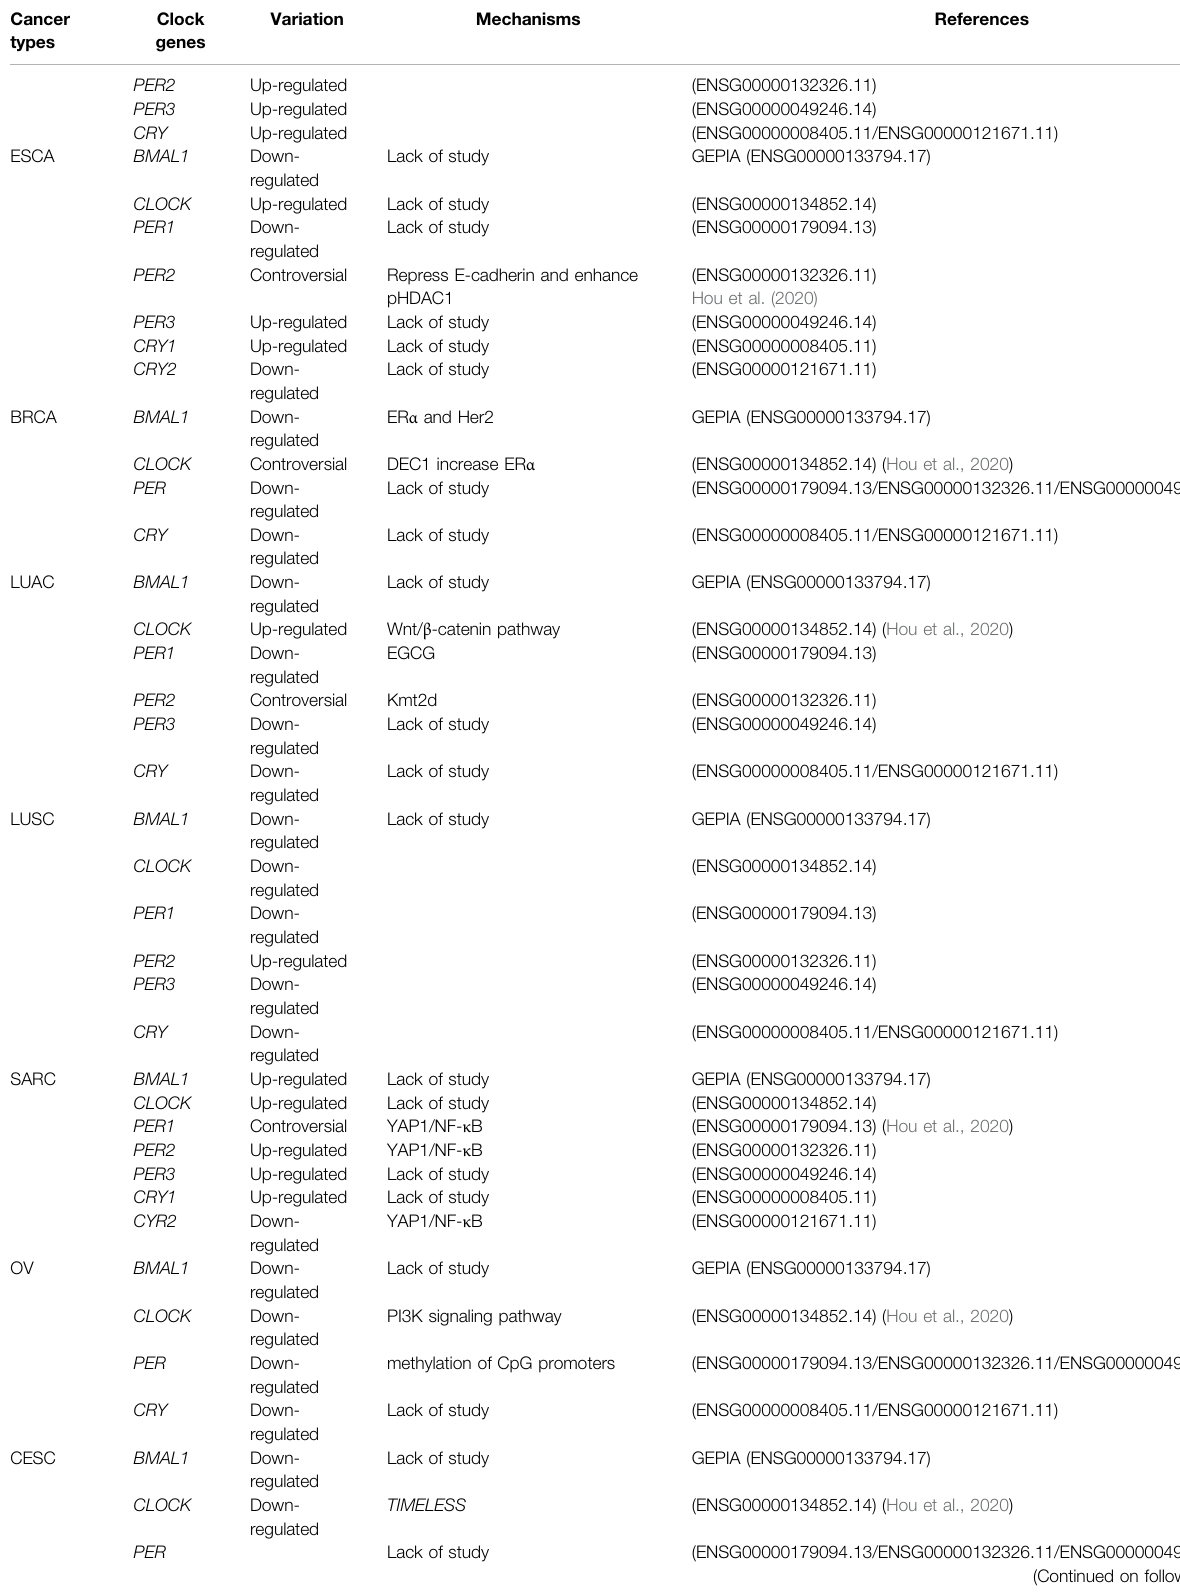
TABLE 1 | ( Continued ) Variational expression of circadian clock genes in different types of